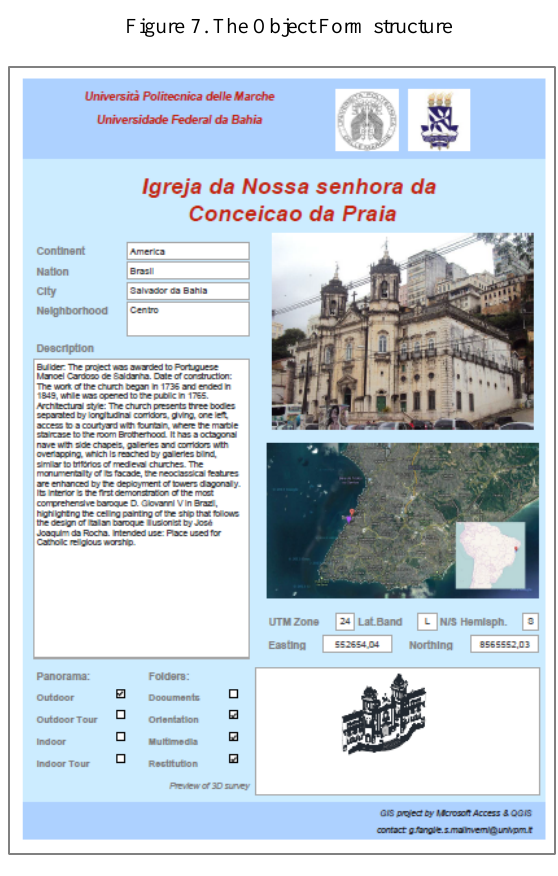
Figure 8. The report in form of data sheet summarizes the information of an architectural heritage stored in the